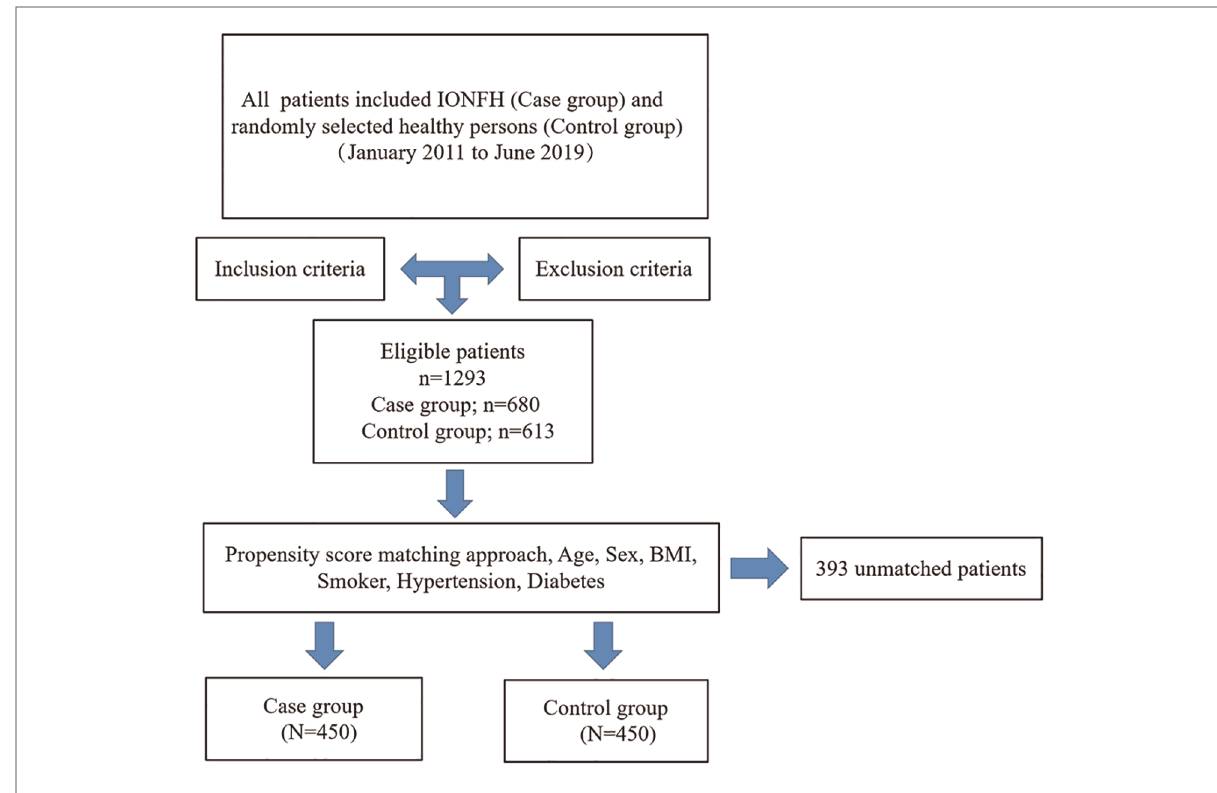
FIGURE 1 Patient selection fl ow chart. IONFH: idiopathic osteonecrosis of the femoral